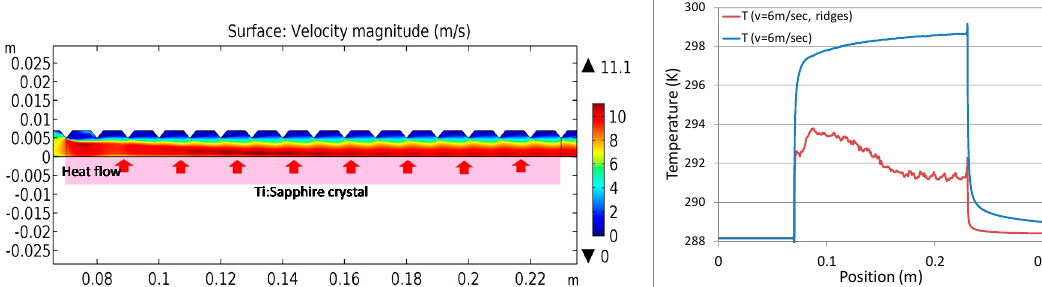
Figure 7. ( Left ) Fluid velocity distribution in the cooling channel, with triangular ridges on the upper wall. The triangular protrusions on the upper wall have a height of 2 mm, base of 4 mm, and distance of 10 mm. The thickness of the channel between the ridges is 7 mm. Other simulation conditions are the same as in Figure 6. ( Right ) Temperature profile along the channel position at the interface between the fluid and the Ti:Sapphire, for the smooth channel (blue line) and for the ridged channel (red line). Such a configuration can be applied for the cooling of the disks in the reflection configuration, as the back face of the cooling channel is not crossed by the light beams, so it can be shaped to optimize heat exchange